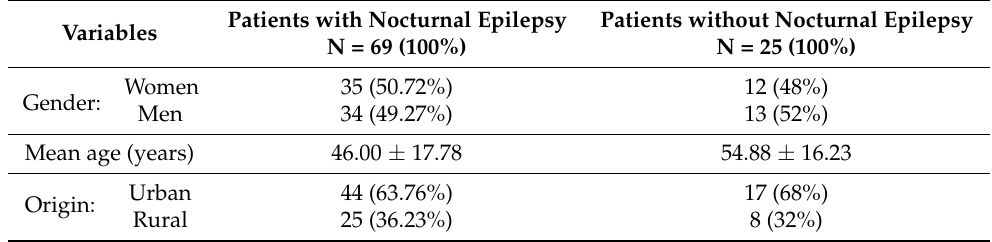
Table 1. Demographic characteristics of